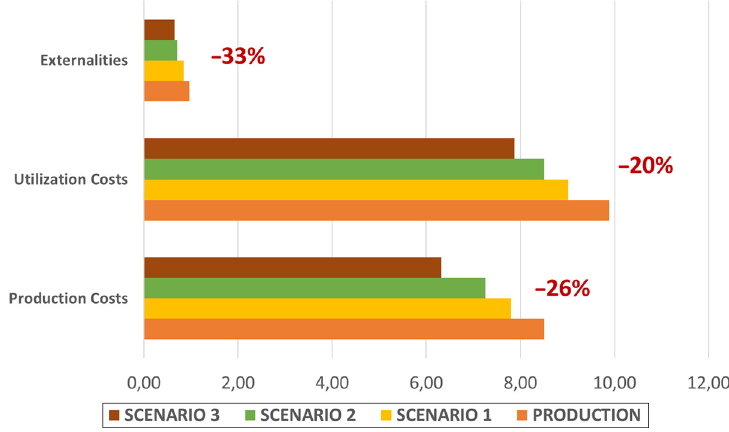
Figure 5. Graphical representation of environmental costs (expressed in e /m 2